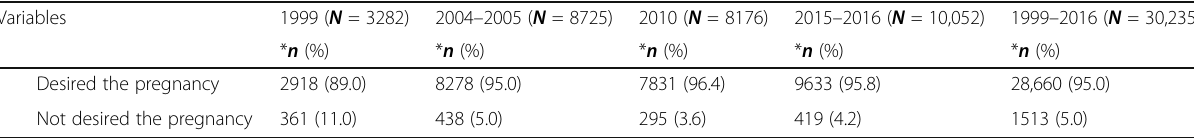
Table 1 Characteristics of the study participants (Continued)